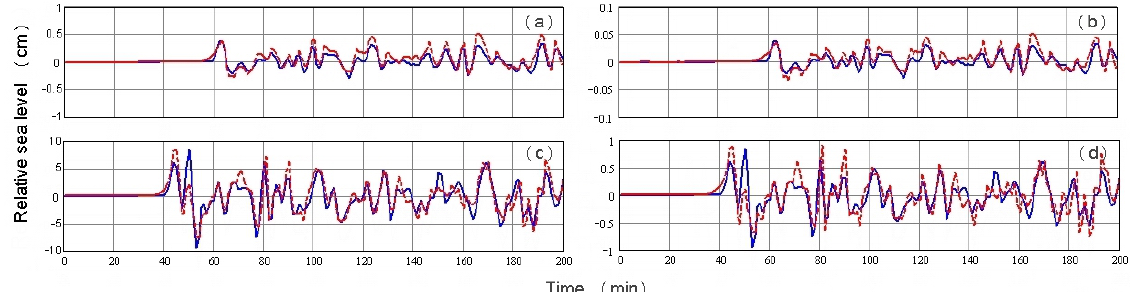
Fig. 3. Illustration of the reciprocity relationships. Elliptic Source T is elongated to the north-west (see Fig. 1). The ratio of major/minor axes is equal to 2.0 (left column) and to 3.0 (right column). Upper row: waveforms at Site T due to Source 1 (blue solid line) and at Site 1 due to Source T (red dashed line); correlation coefficients are ρ 12 = 0.90 (a) and ρ 12 = 0.87 (b) . Lower row: waveforms at Site T due to Source 2 (blue solid line), and at Site 2 due to Source T (red dashed line); correlation coefficients are ρ 12 = 0.86 (c) and ρ 12 = 0.78 (d)